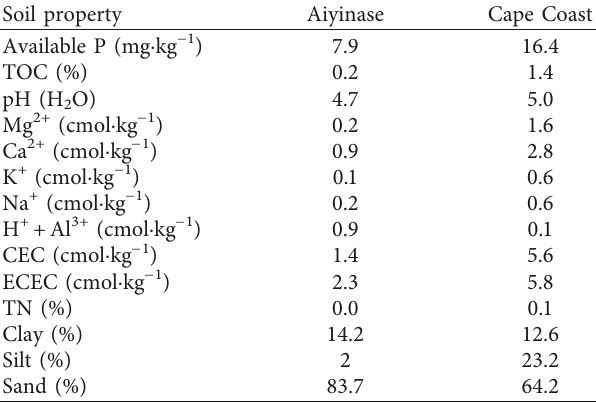
Table 1: Physicochemical properties of the Cape Coast and Aiyinase soils used in the study.